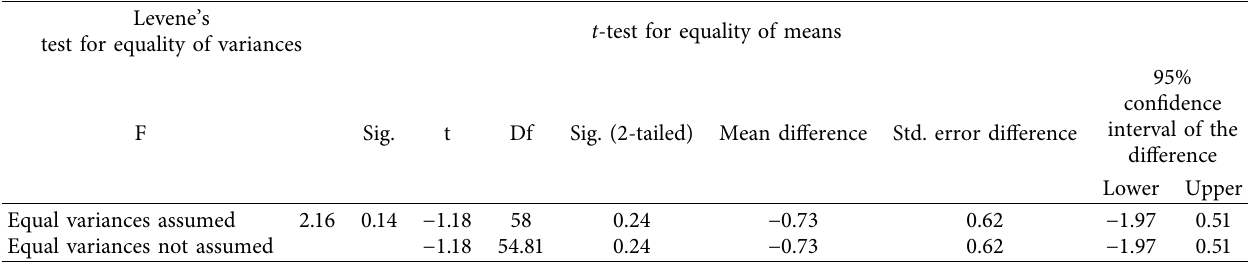
Table 7: Inferential statistics of the experimental and control groups in the vocabulary pretest.